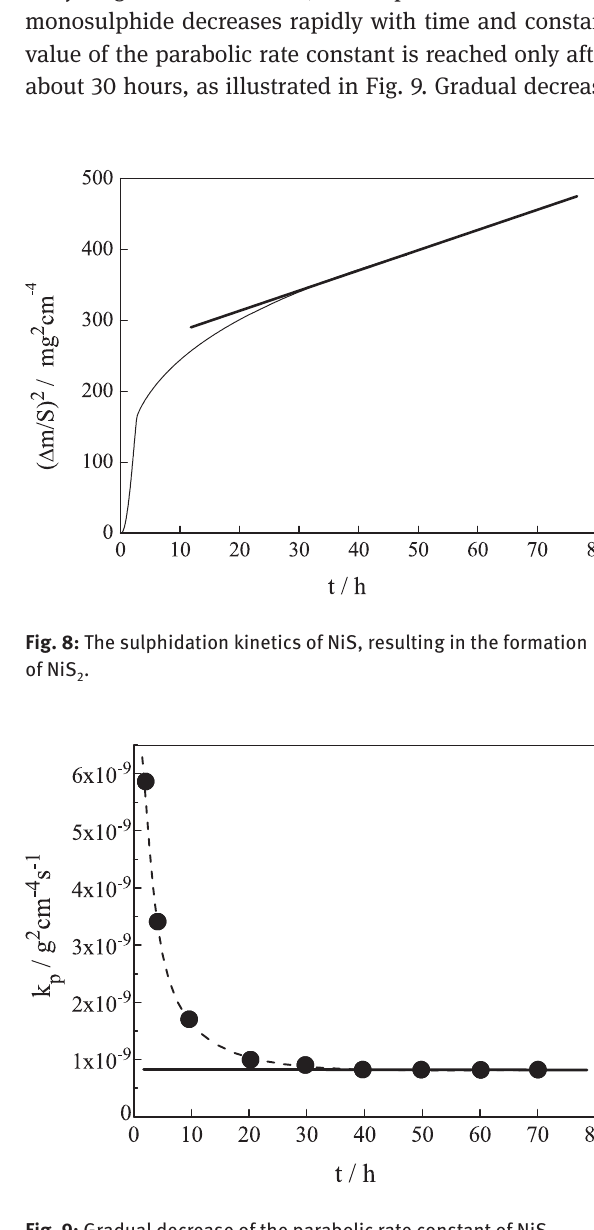
Fig. 9: Gradual decrease of the parabolic rate constant of NiS 2 formation in early stages of the